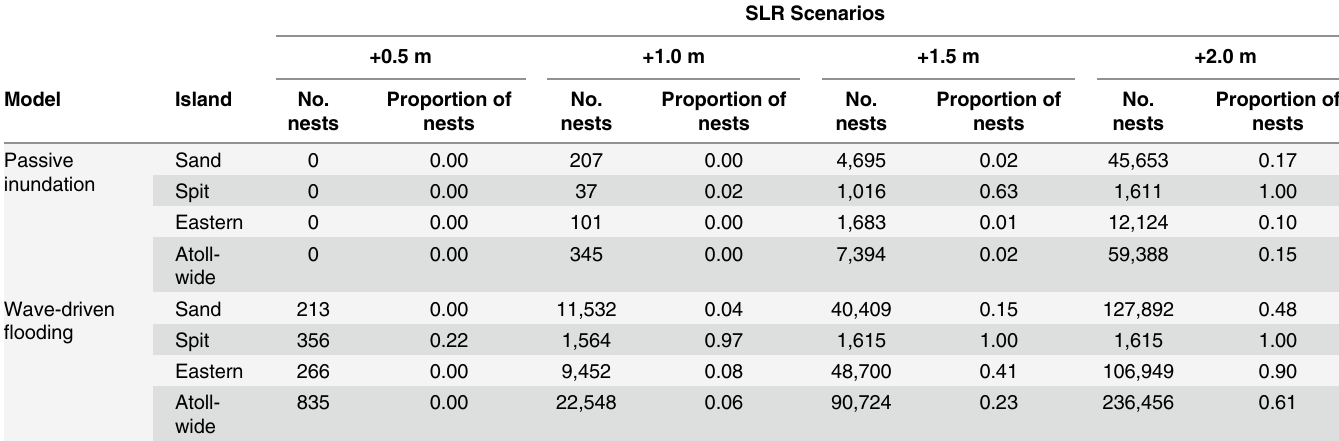
Table 4. Projected Laysan albatross nest inundation at Midway Atoll for four sea-level rise scenarios and two inundation models, including groundwater rise. Nest inundation based on the 2011/2012 breeding season nest census at Sand (267,978 nests), Spit (1,615 nests), and Eastern (118,424 nests) islands, totalling 388,017 nests